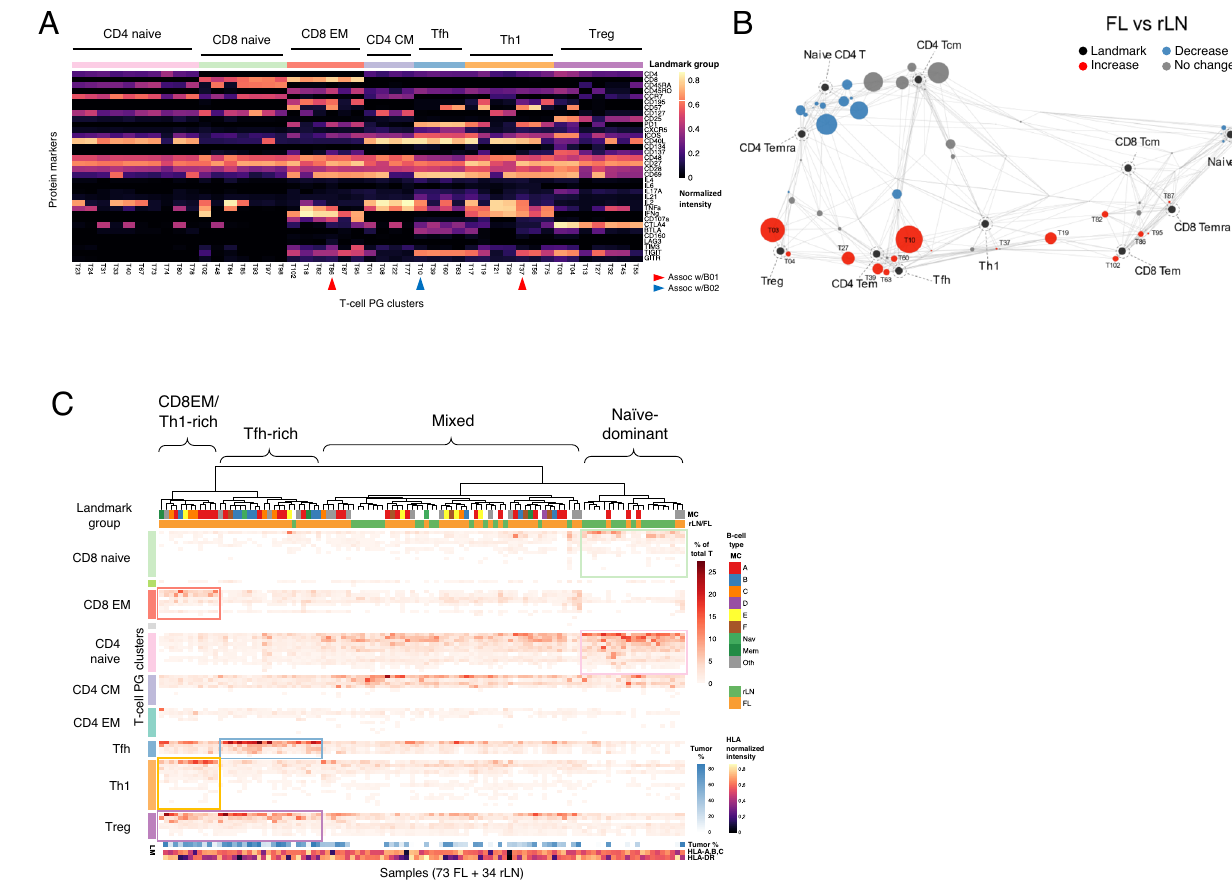
Fig. 4 | FL samples exhibit a spectrum of T-cell states. A Protein expression heatmap of T-cell PG clusters. Median expression values from CyTOF data are depicted foreachcluster.Landmarkgroupannotationswereassignedmanuallyby proximityinScaffoldmap( B ).Thetop45mostpopulatedPGclustersaredepicted. T-cell clusters associated with B01/B02 B-cell clusters are highlighted (see Fig. 5a). B ScaffoldmapofT-cellpopulationsinrLNandFLsamples.Eachnoderepresentsa T-cellPGclusterwithsizeproportionaltoitsmedianpercentageacrossallsamples. Landmark nodes are sizelessreferencepoints de fi ned by canonicalmarkers. Edges are of length inversely proportional to phenotypic similarity. Nodes are colored according to statistically signi fi cant differences in abundance for the comparison